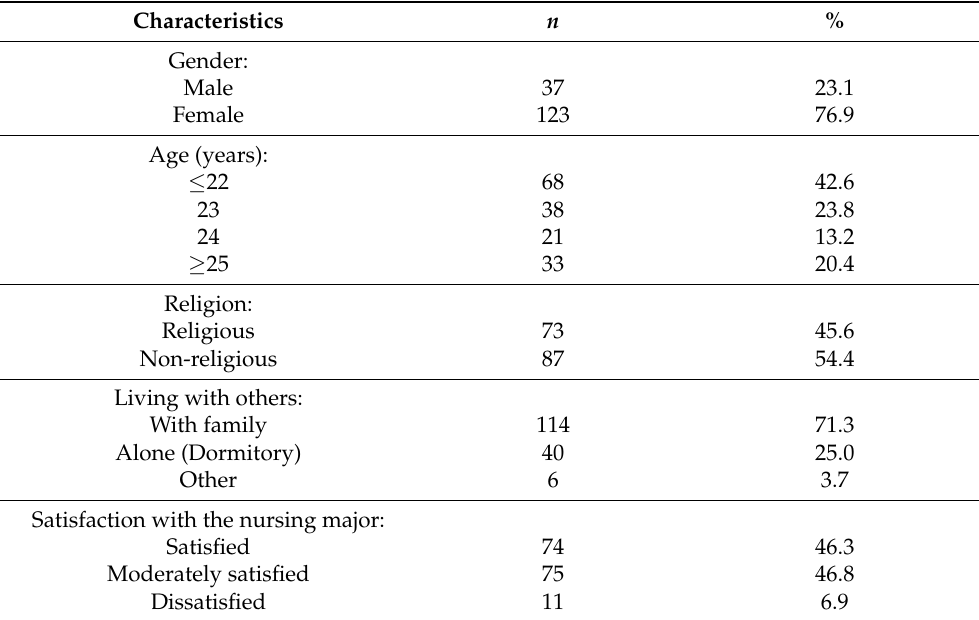
Table 1. General characteristics of study